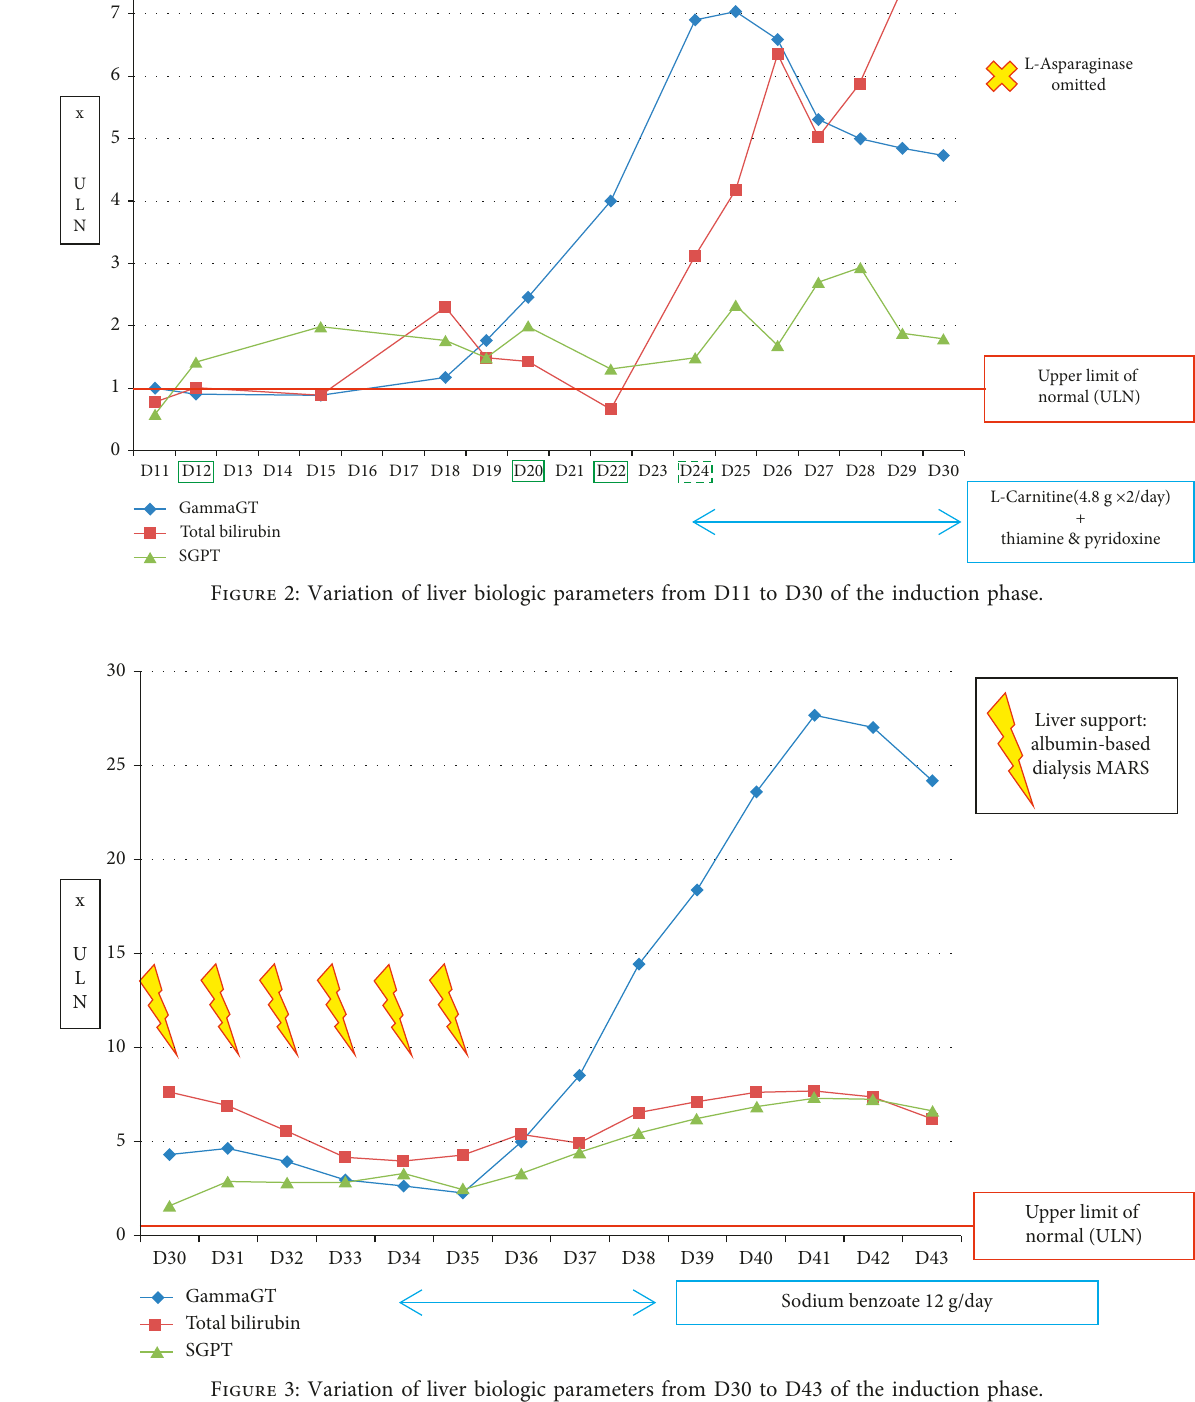
Figure 3: Variation of liver biologic parameters from D30 to D43 of the induction